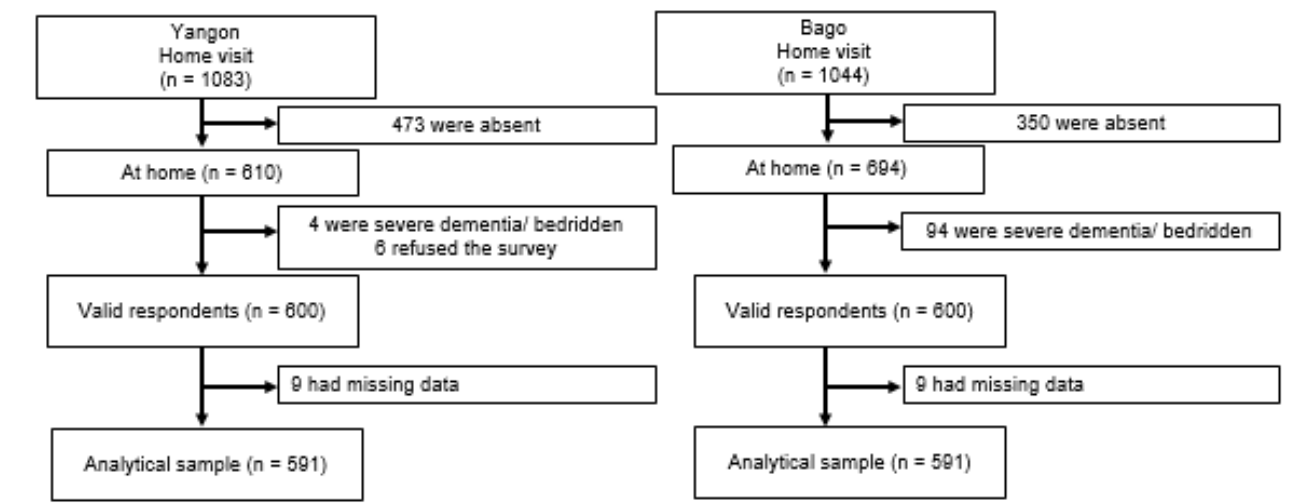
Figure 1. Selection of participants for a study.